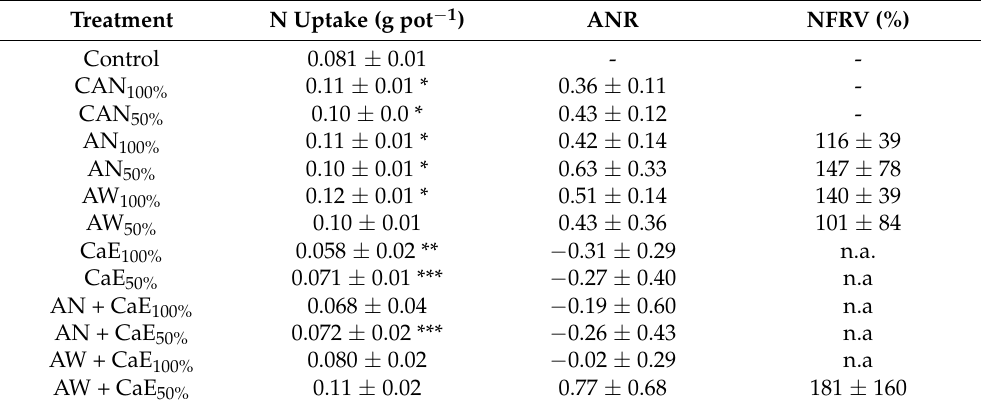
Table 7. Mean ± standard deviation of apparent nitrogen recovery (ANR) for all fertilized treatments, and the nitrogen fertilizer replacement value (NFRV) of the tested products (n = 4). Treatment N Uptake (g pot − 1 )